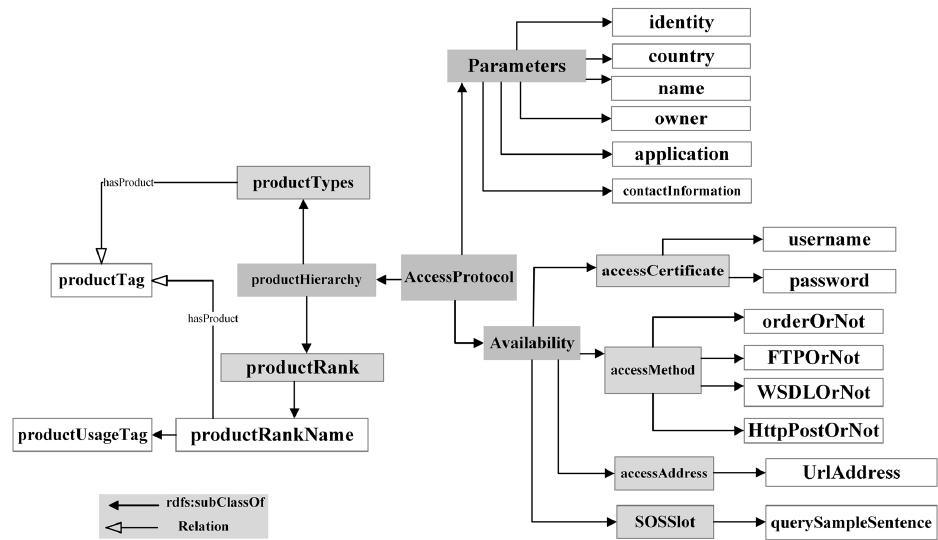
Figure 2. Access protocol model, containing the access protocol information, product information and the availability